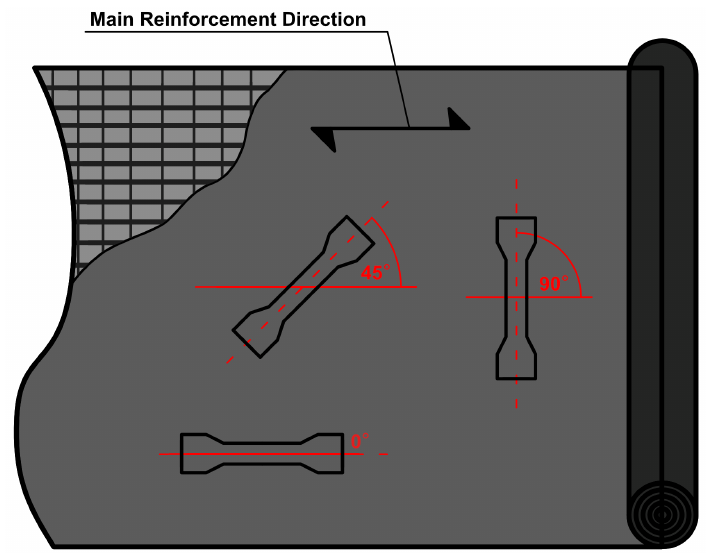
Figure 3. The direction in which the specimens were cut from the sheet (solid red lines represent the main direction of reinforcement).